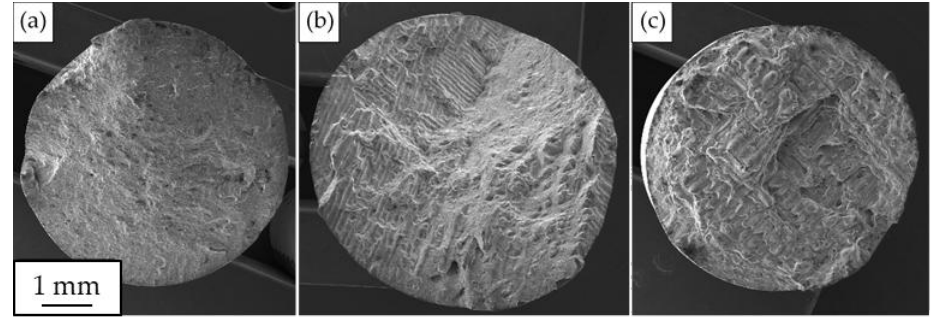
Figure 10. Fracture surfaces after tensile test in scanning electron microscope: ( a ) 0°-specimen; ( b ) 45°-specimen; and ( c ) 90°-specimen.